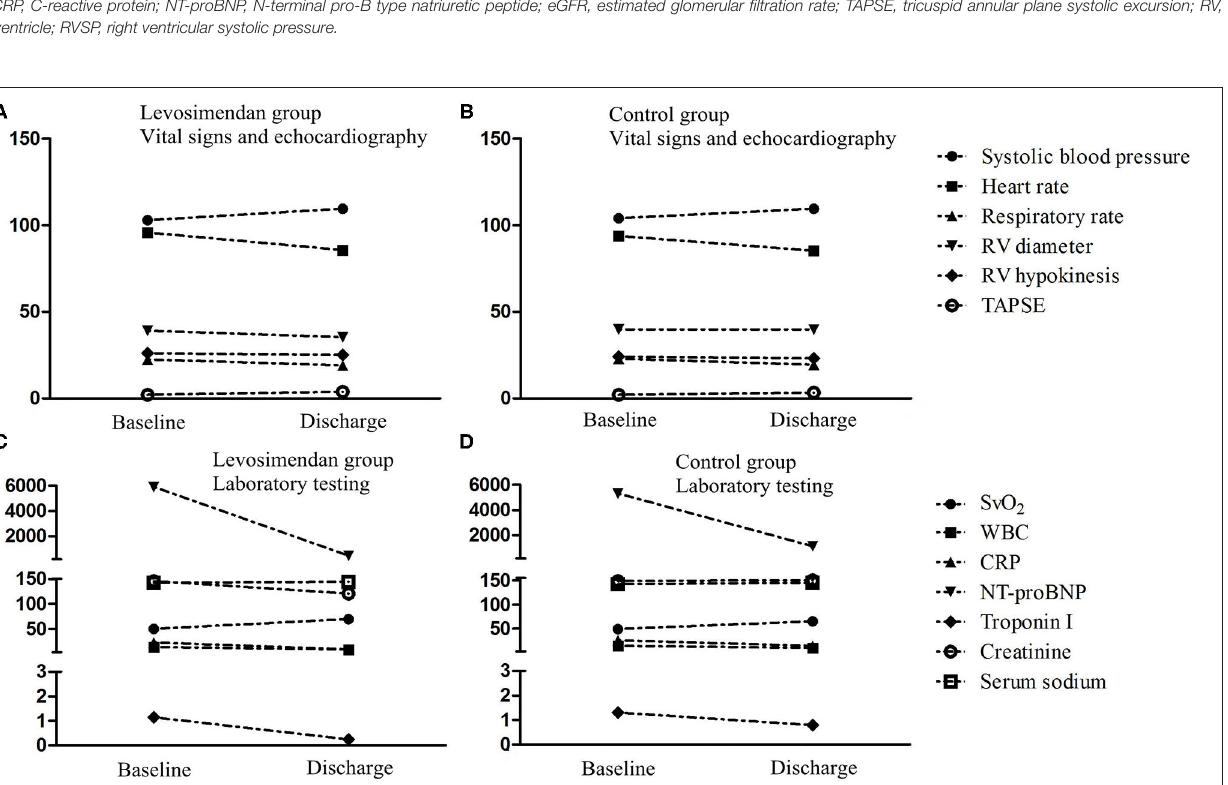
Frontiers in Medicine |